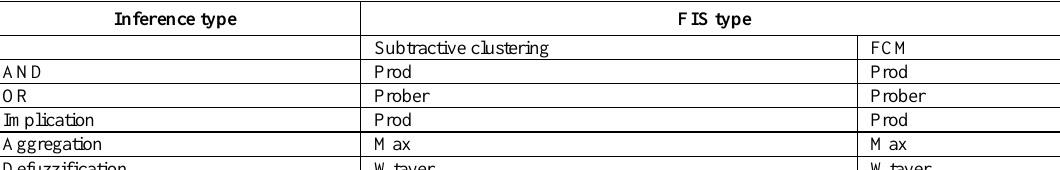
Table 6. Parameters of the constructed model based on FIS